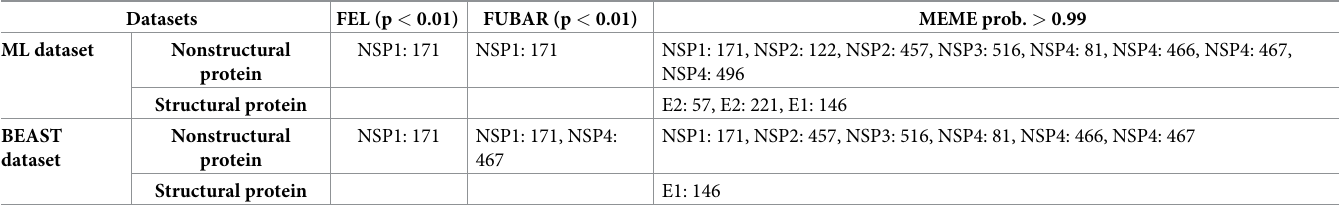
Table 2. Site-specific selection pressure estimates based on two different datasets (BEAST = 247 genomes and ML = 130 genomes).